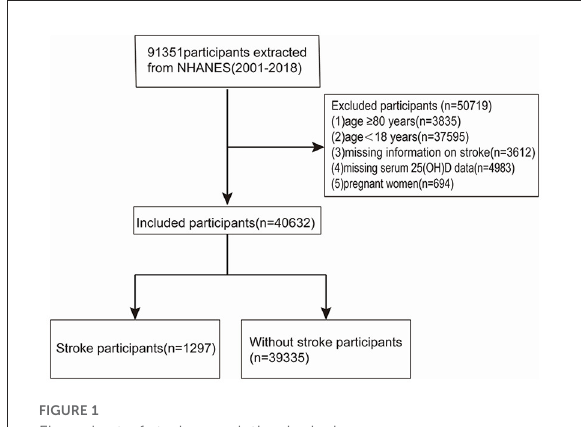
FIGURE1 Flow chart of study population